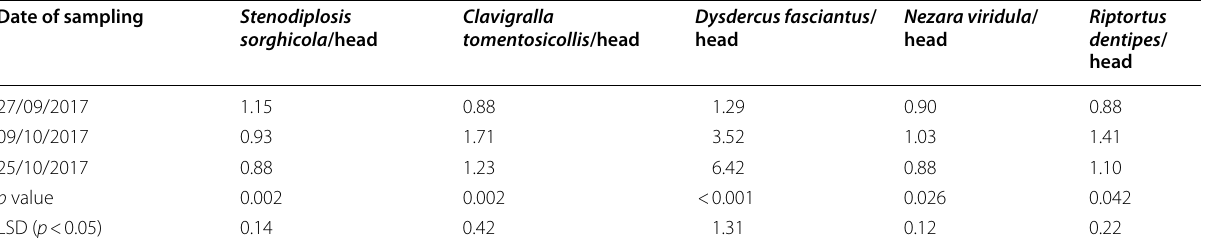
Table 1 Panicle‑feeding insect pest mean infestations on sorghum heads at different dates of sampling in the 2017 cropping season